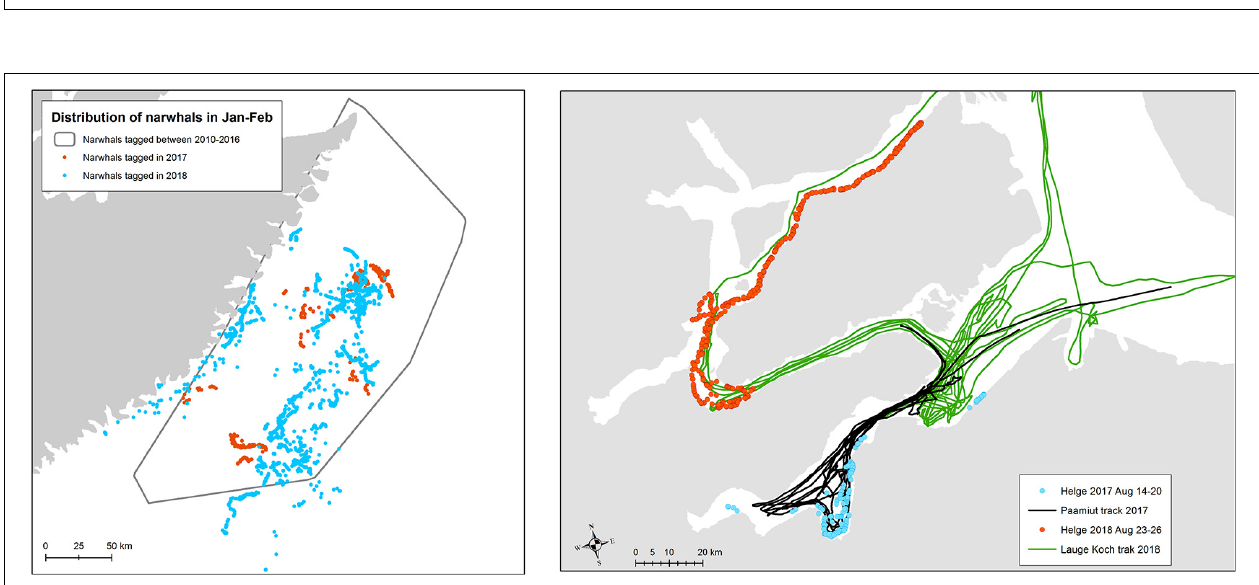
FIGURE 4 | Left Winter positions of whales tracked in 2017 and 2018 during the winter months (January–February, n = 10) following exposure, compared to the minimum convex polygon of winter positions of 12 reference whales tracked in 2010–2016. Right Positions and exposure to seismic vessels of one whale (A1/B1) tagged in both 2017 and